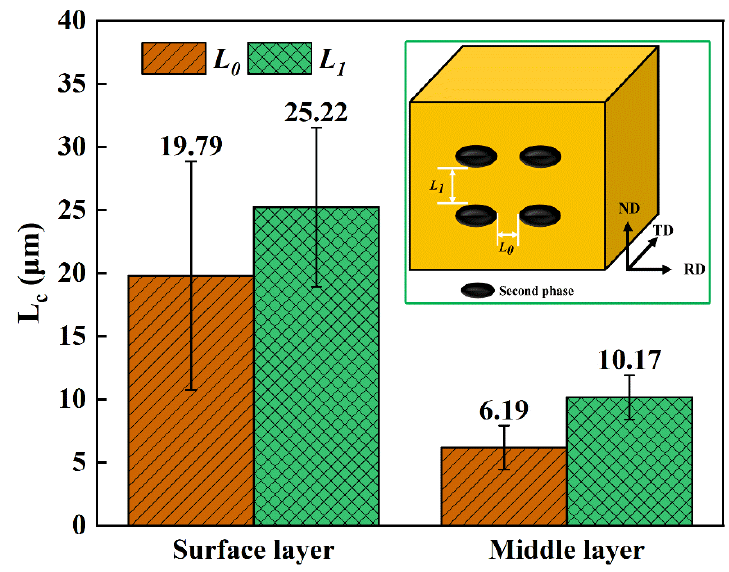
Figure 7. The average spacing of the second phase in the different directions.